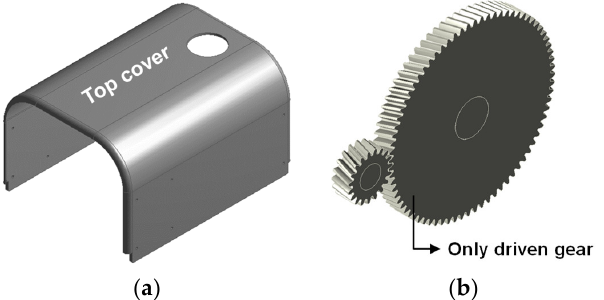
Figure 8. Design variable–Material: ( a ) Case 3: Top cover material change from polycarbonate to Al6061-T6; ( b ) Case 4: Driven gear material from S45C to polycarbonate.